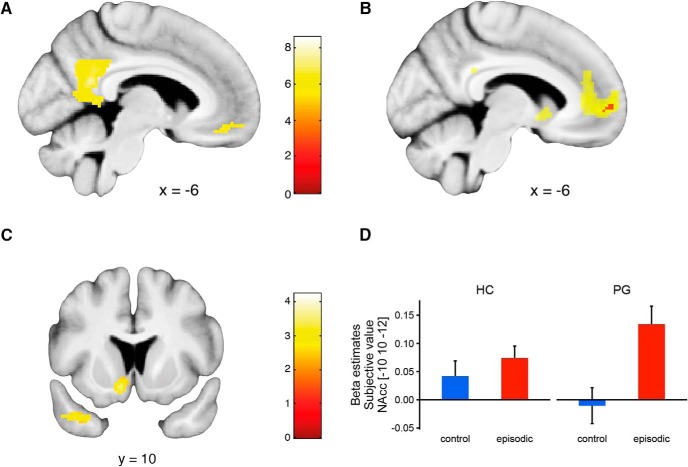
A, Categorical analysis (episodic > control condition, conjunction analysis across pathological gamblers and healthy controls, FWE whole-brain peak-level corrected, p < 0.05) revealed activity in precuneus and vmPFC. B, Main effect of subjective value pooled across both experimental conditions, conjunction across pathological gamblers and healthy controls. Red, FWE whole-brain peak-level corrected, p < 0.05; yellow, p < 0.001 uncorrected. C, Increased value signals in the episodic condition compared with the control condition in the left NAcc, p < 0.01 uncorrected for display purposes. D, β estimates extracted from the peak voxel of C in the left NAcc (this plot serves to visualize the direction of effects, not for statistical inference). PG, pathological gamblers; HC, healthy controls. Error bars indicate ±1 standard error of the mean.